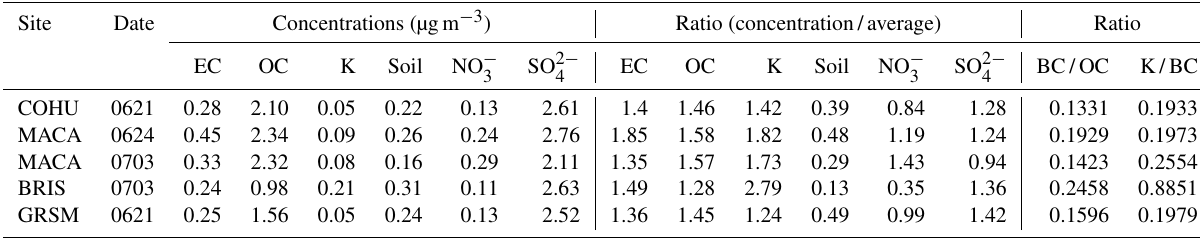
Table 2. Identified fire signals from IMPROVE measurements during SENEX.